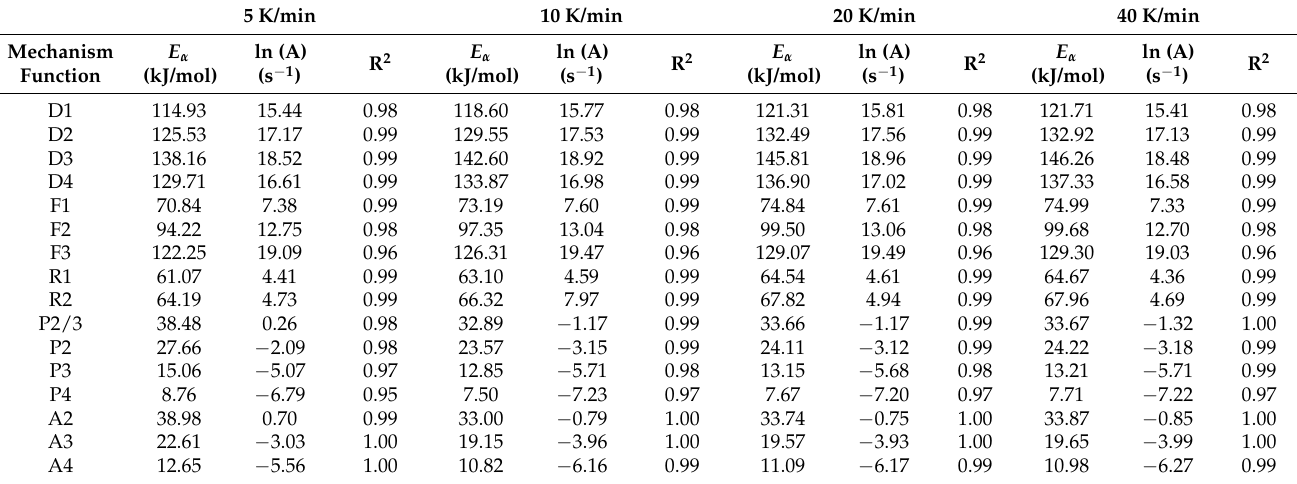
Table 6. Activation Energy and ln A of Natural Aging—100 Chinese Fir under Different Mechanism